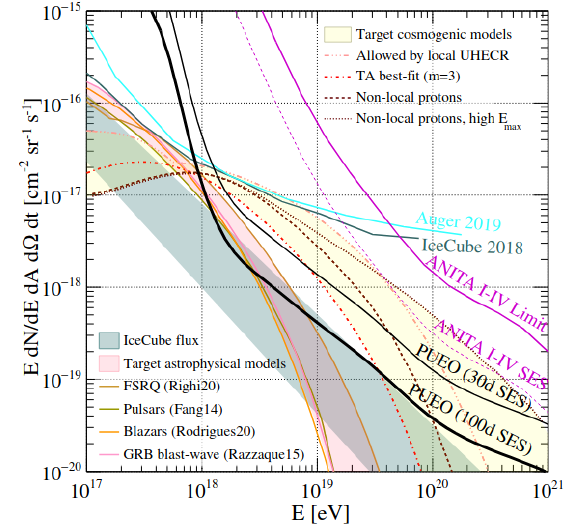
Figure 5. PUEO’s single-event sensitivity (SES) to di ff use neu- trinos for 30 d and 100 d fl ights. Also shown are existing limits set by various experiments and some cosmogenic and astrophys- ical models